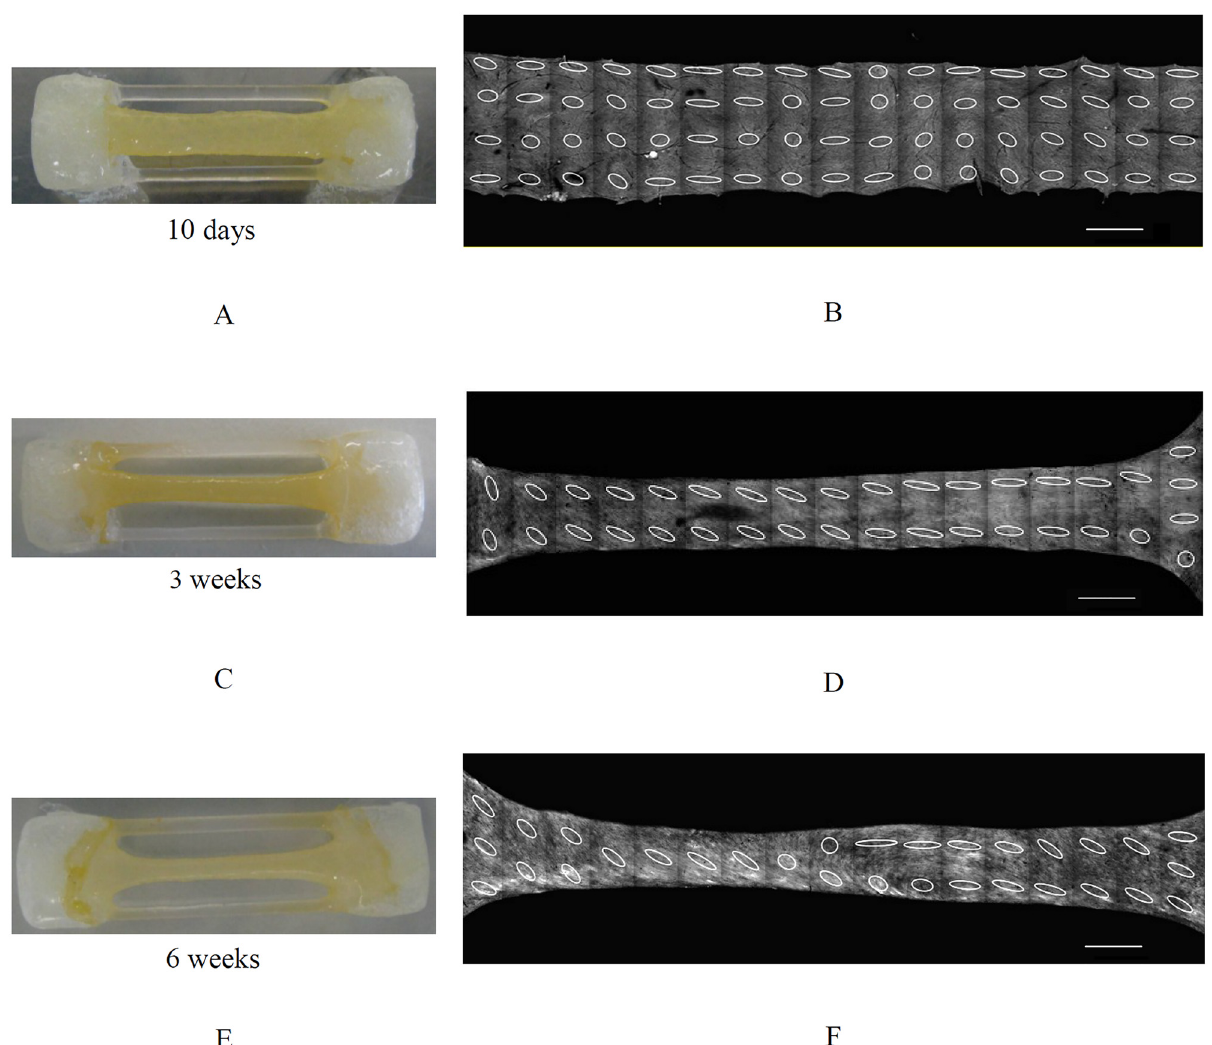
Fig 4. Macroscopic images of high aspect ratio TE strips cultured for 10 days (A), 3 weeks (C) and 6 weeks (E) and their corresponding CLSM images (B, D, F). (Strip size: 25×3×1 mm) collagen fiber alignment changed to the constrained direction with time and changed to the oblique direction in regions where compaction is more pronounced. Scale bars represent 1